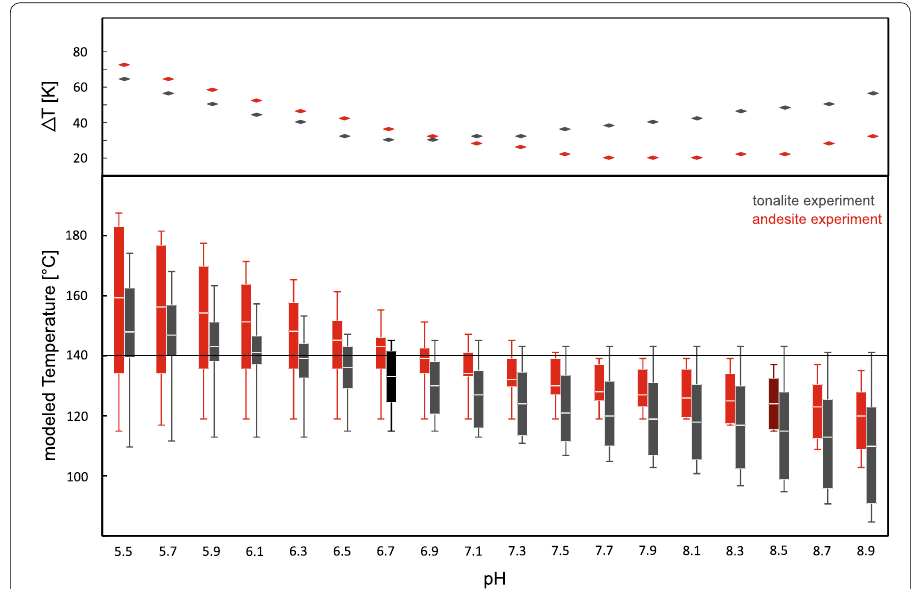
Fig. 6 Distribution of calculated temperatures for the laboratory experiments using multicomponent geo- thermometry together with the according temperature spreads ( ΔT ) plotted versus solution pH. Measured pH is indicated in black (tonalite experiment) and dark red (andesite experiment)